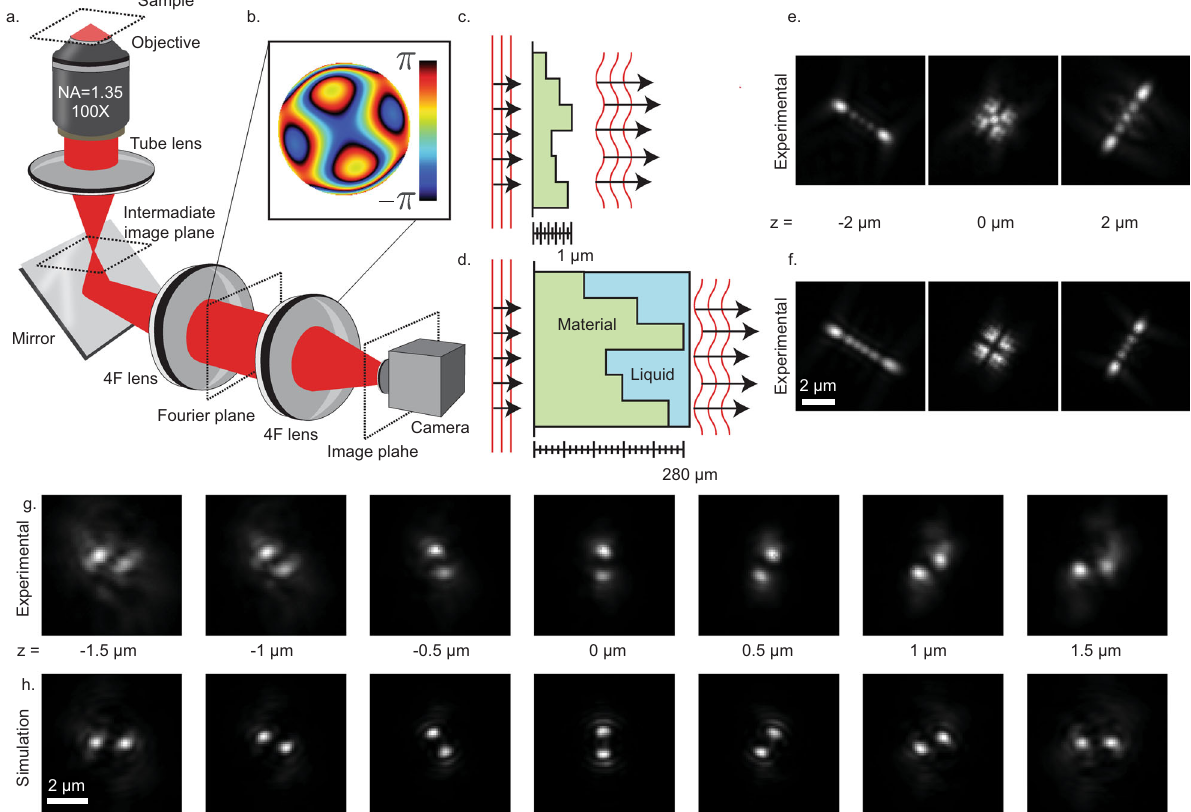
Fig. 1 The concept of the liquid immersed phase mask. a The optical system, an inverted microscope expanded with a 4F system. b A phase mask, implemented in the Fourier plane. c Schematic of a conventional photolithographically fabricated phase mask (side view), with etching depth up to 1 µ m. d Schematic of a liquid immersed phase mask (side view), fabricated with additive manufacturing, with height up to 280 μ m. e , f Experimental images of a fl uorescent microsphere at different axial positions, using the two different phase masks. Note that the small differences in the PSF shape are derived from the differences in mask designs (Supplementary Fig. 1). g Experimental and ( h ) simulated images of a fl uorescent microsphere at different axial positions, using a liquid-immersed Double Helix phase